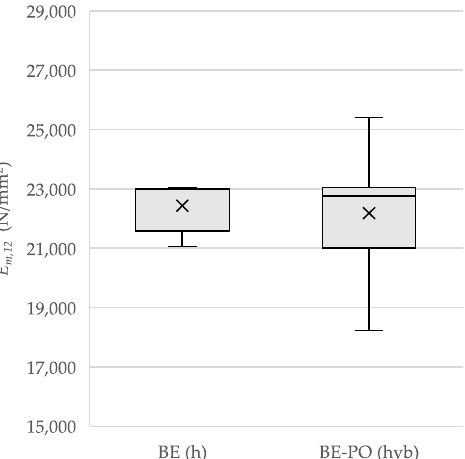
Figure 11. Test results of the modulus of elasticity of the glue-laminated beams in the four-point bending test displayed in a box plot.